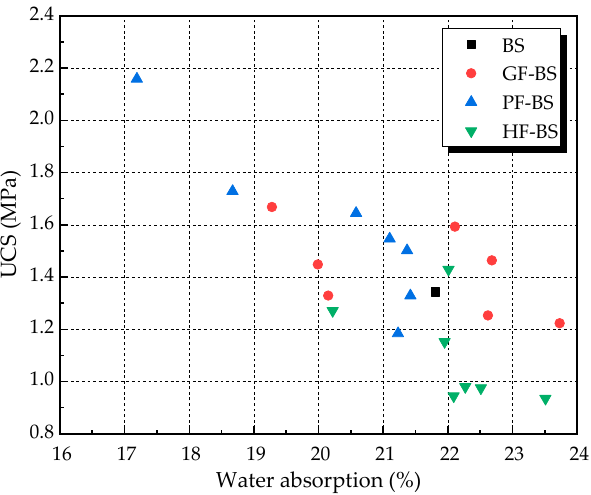
Figure 9. UCS and water absorption.